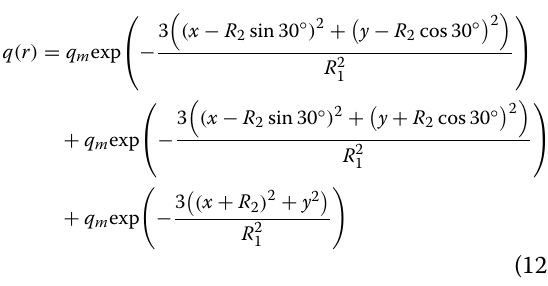
Distances with Various Parameter Combinations A process map based on the experiments listed in Table 2 at defocus distances ranging from 0.5 mm to 3.5 mm − − with various parameter combinations is shown in Fig- ure 13. Different surface characteristics are generated by various combinations of the defocus distance with laser power, scanning speed, and wire feeding speed. In the process map, regions 1–5 representing the observed characteristics including dripping, possible dripping,